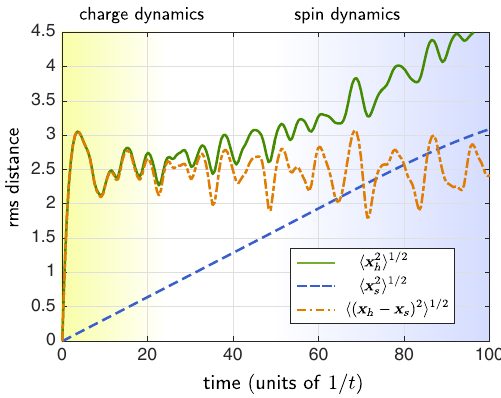
FIG. 21. Far-from-equilibrium dynamics of an initially local- 0 . 5 t , as in Fig. 20. The rms ized hole in the t - J model at J z z ¼ distance h ˆ x 2 i 1 /2 of the hole density distribution h ˆ n h ð x Þi is h dominated by fast charge dynamics at short times, and by slow spin dynamics at long